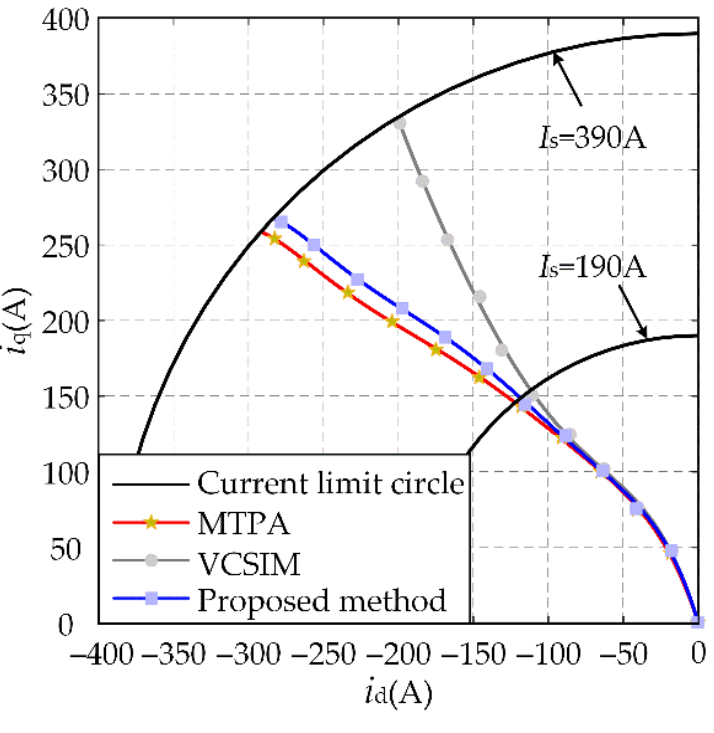
Figure 6. MTPA tracking experimental result of VCSIM and proposed method when the motor speed is 1000 r/min.